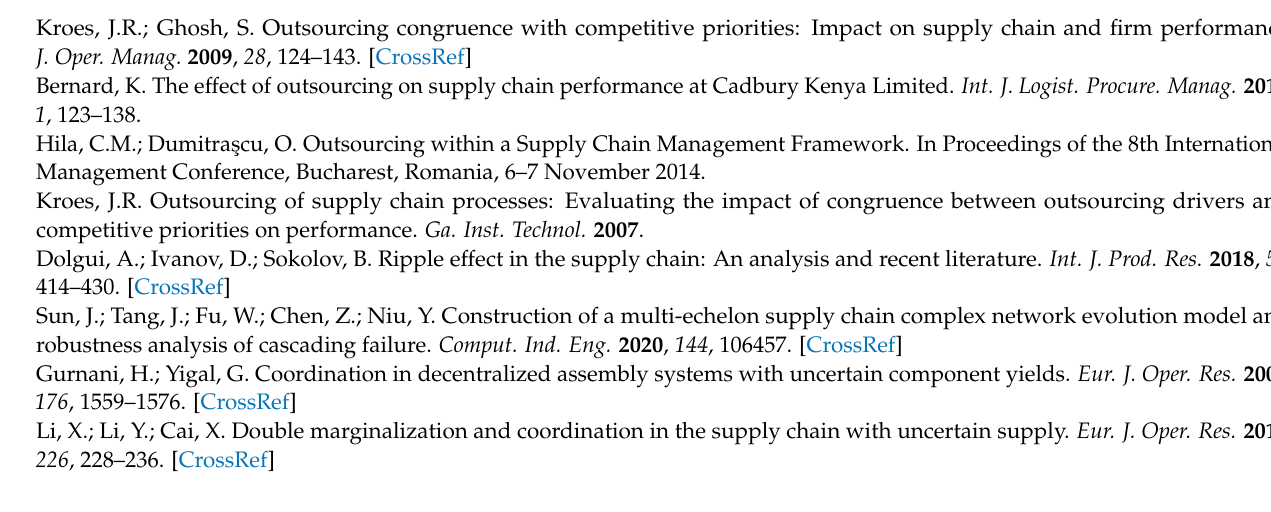
Figure A4. Sensitivity analysis graph for setup cost and total cost.